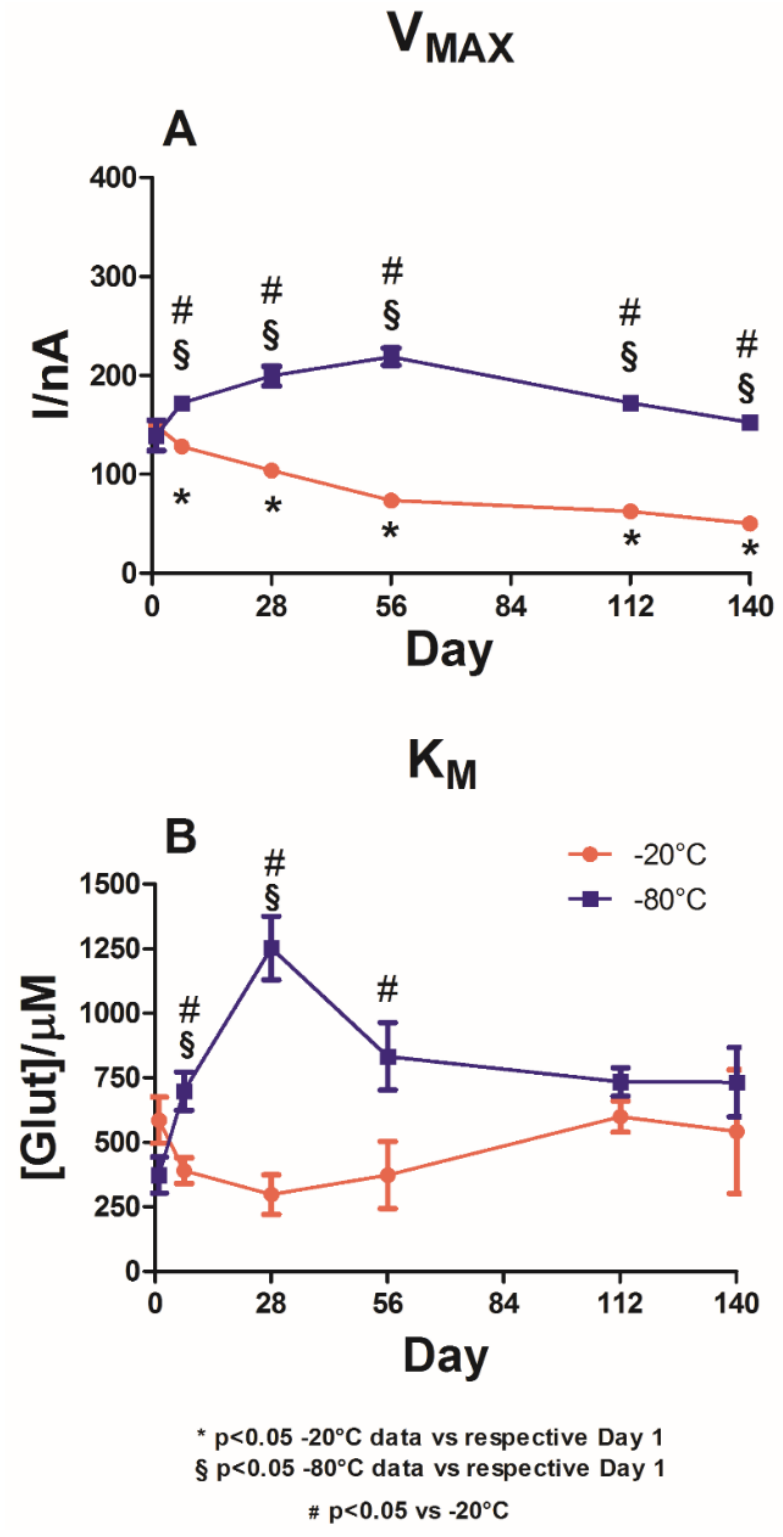
Figure 2. Graph describing the variations of V MAX (Panel ( A )) and K M (Panel ( B )) over a range of 140 days in the control biosensor design Pt c /PPD/PEI(1%) 2 /GlutOx 5 at −20 °C (red plot) and −80 °C (blue plot). The subscript numbers represent the numbers of deposition steps, while the concentrations of the component are recorded in bracket. Pt c : Pt cylinder 1 mm long, 125 µ m in diameter; GluOx: L-glutamate oxidase; PPD: poly-ortho-phenylenediamine; PEI: polyethyleneimine. As shown in panel A, a −20 °C storage temperature yielded significant variations in V MAX (app) values over time when compared to Day 1. The V MAX (app) values experienced a sig- nificant decrease between Day 1 and Day 7, reaching 128.0 ± 3.4 nA. This downward trend was maintained until Day 140, when V MAX (app) ) reached 50.1 ± 3.6 nA, although the figures were still significantly lower ( p < 0.05) than those on Day 1. In the blue plot in Panel A, the V MAX (app) variations are reported for the biosensors stored at −80 °C. As shown in this panel, V MAX s (app) experienced a significant increase on Day 7, arriving at the value of 171.8 ± 4.4 nA by Day 56. Subsequently, a downward trend was recorded up to Day 140, when V MAX (app) reached a value of 152.4 ± 6.8 nA. Throughout the observation period, V MAX (app) was significantly higher ( p < 0.05) than the value on Day 1.